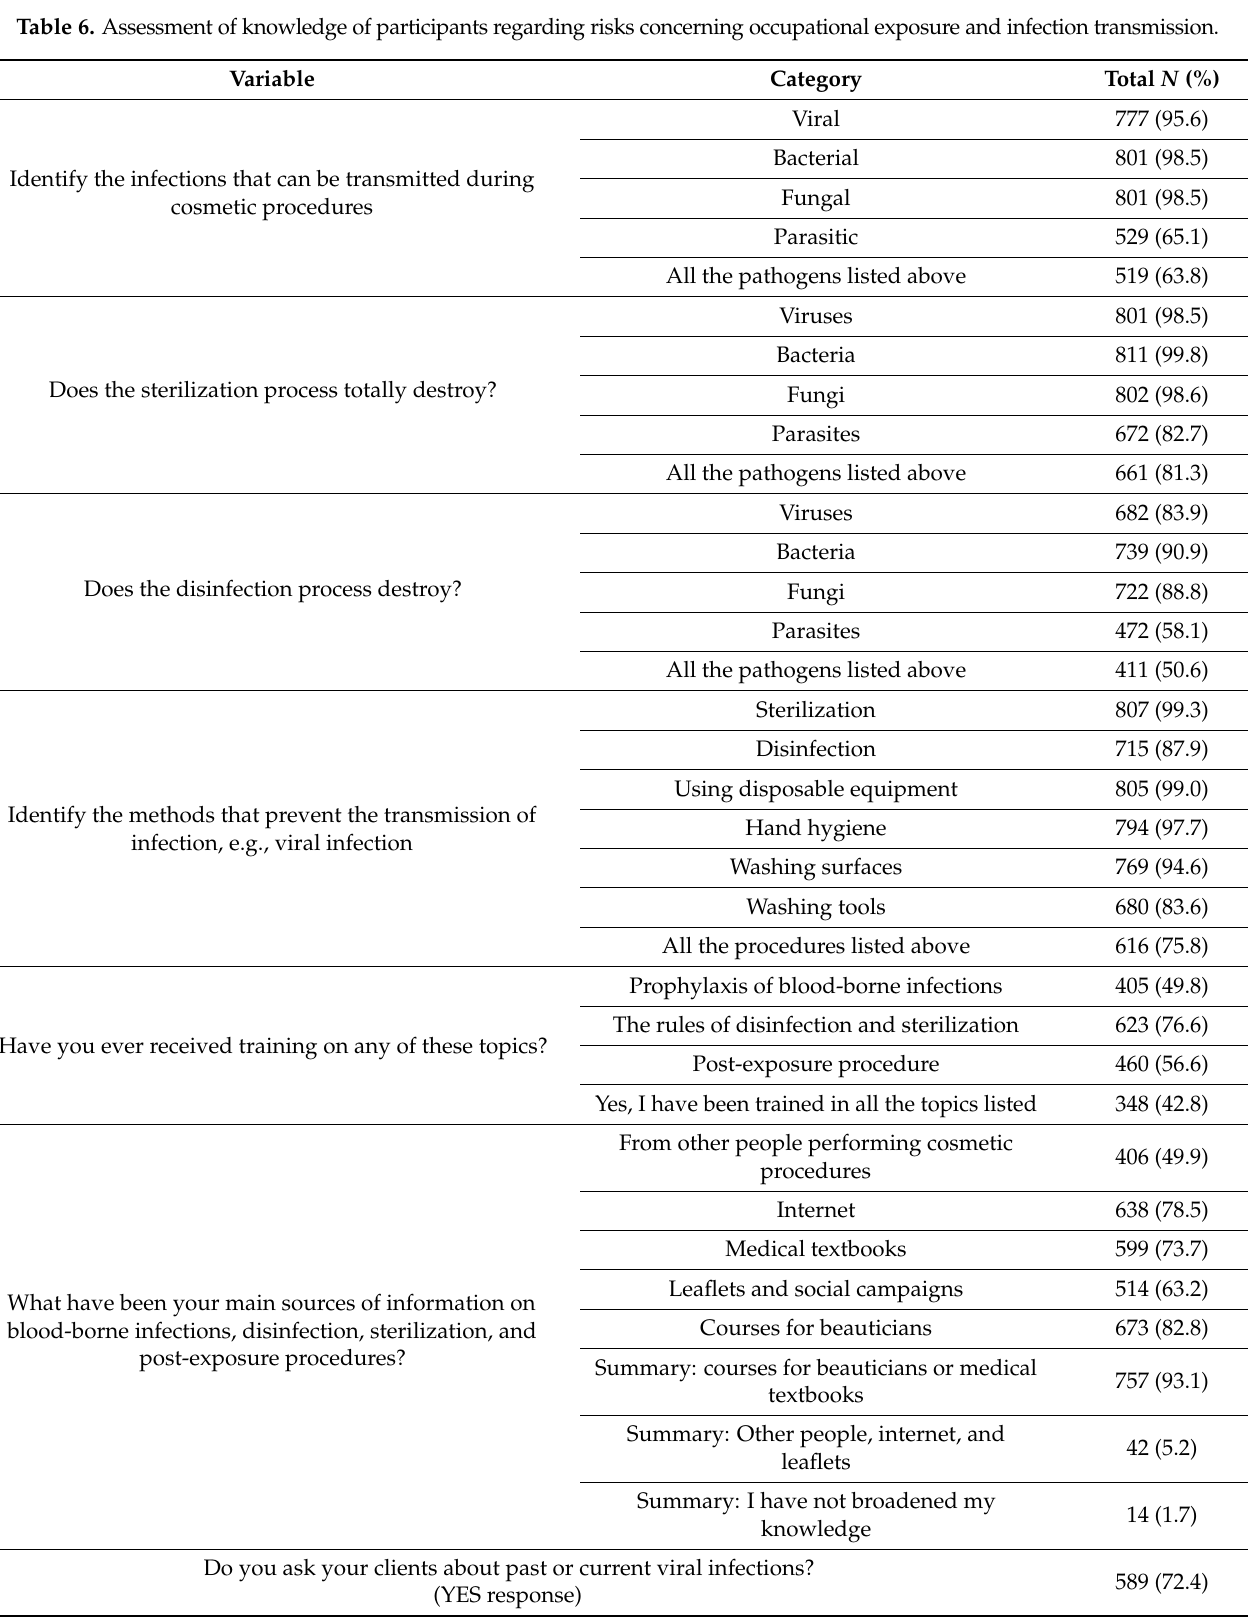
Table 6. Assessment of knowledge of participants regarding risks concerning occupational exposure and infection